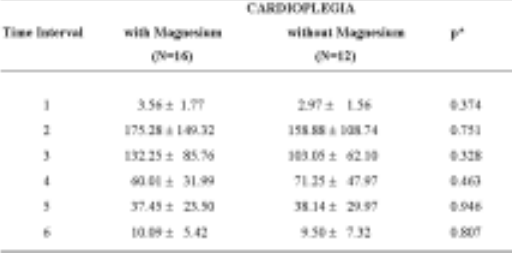
Table 2. Mean values and standard deviation of CK-MB mass (ng/mL) according to the time intervals and the cardioplegia